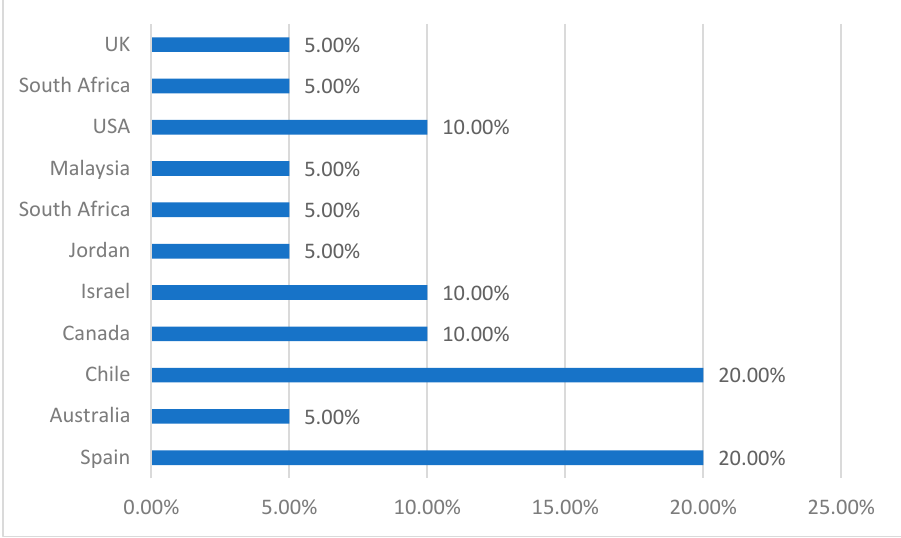
Figure 3. Studies by country of publication.